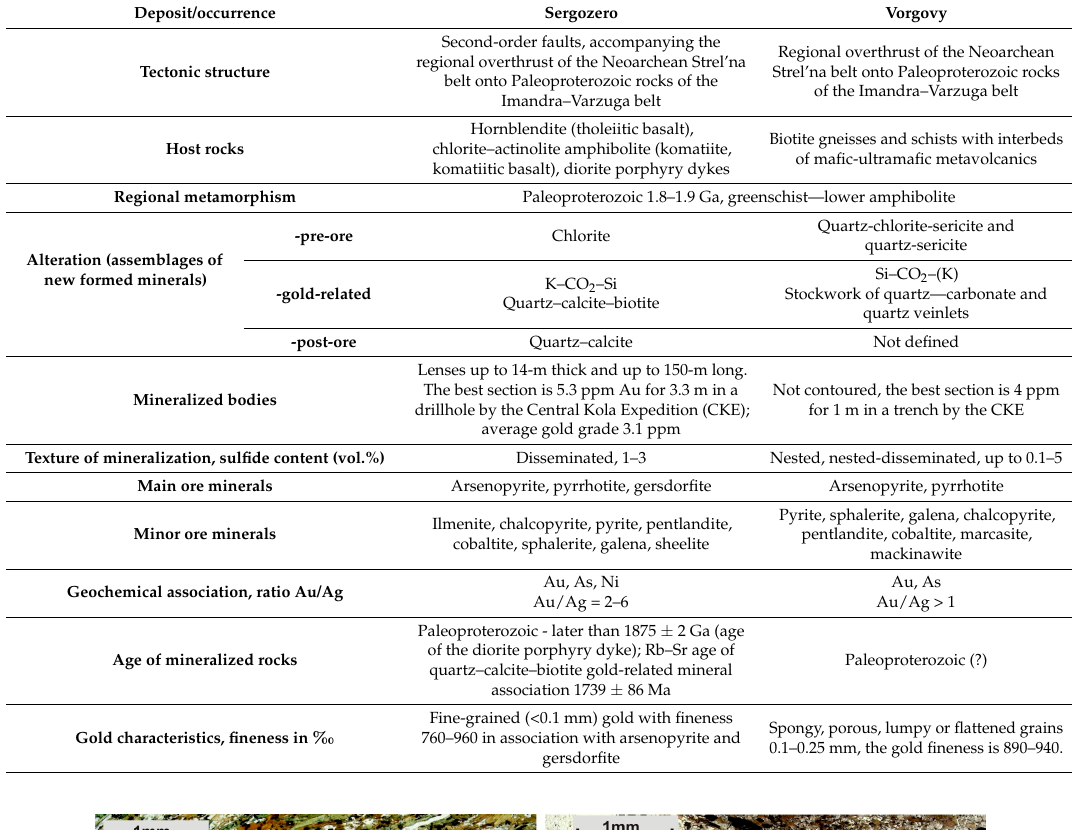
Table 6. General characteristics of the gold deposits in the Strel’na greenstone belt.